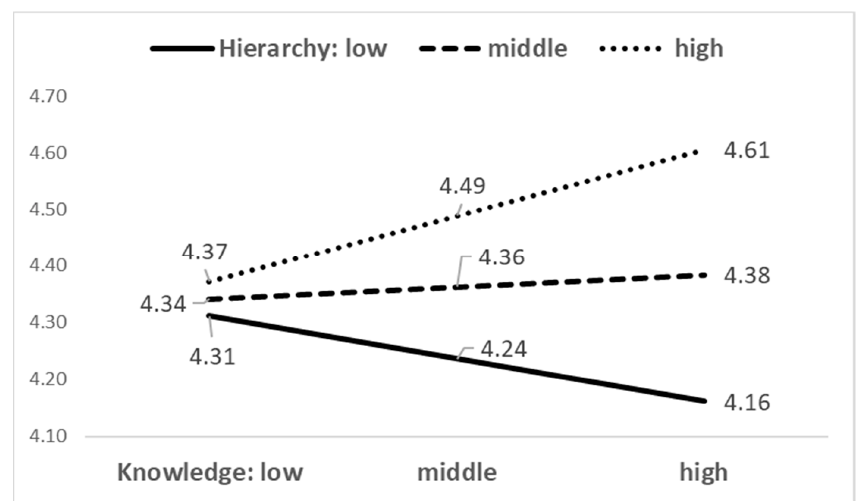
Figure 11. Knowledge (IV) × hierarchy (M) = skepticism (DV). Figure 11 . Knowledge (IV) × hierarchy (M) = skepticism (DV). Figure 11 . Knowledge (IV) × hierarchy (M) = skepticism (DV).